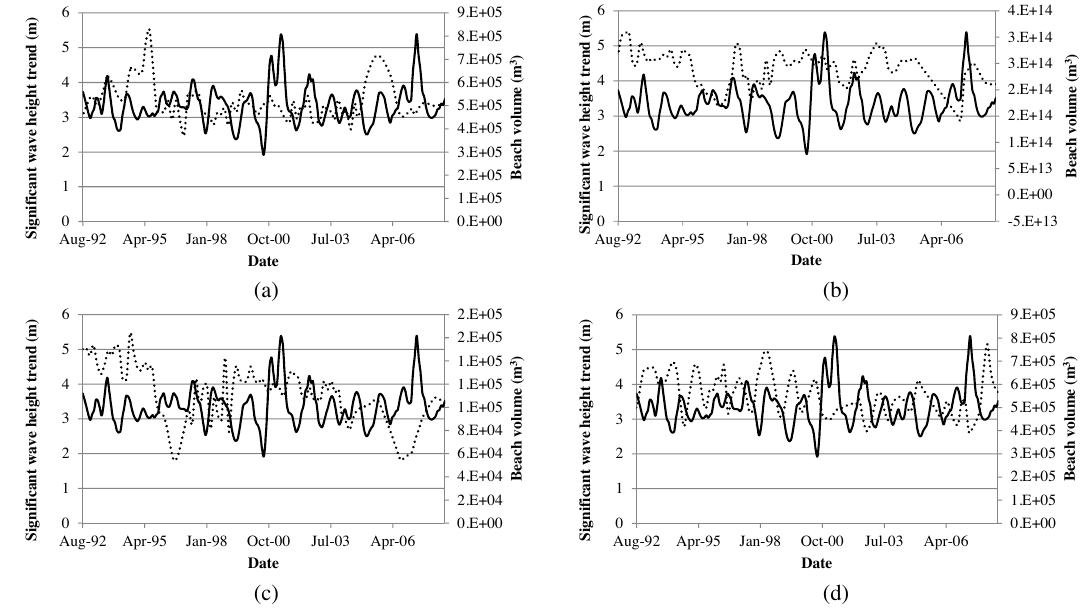
Fig. 8. The relationship between the significant wave height trends (shown by the solid line) and the beach volume trends (shown by the dotted line) for the blocks (a) B–F, (b) 1–18, (c) 19–23, (d) BR6–BR9 (refer to Fig.3).